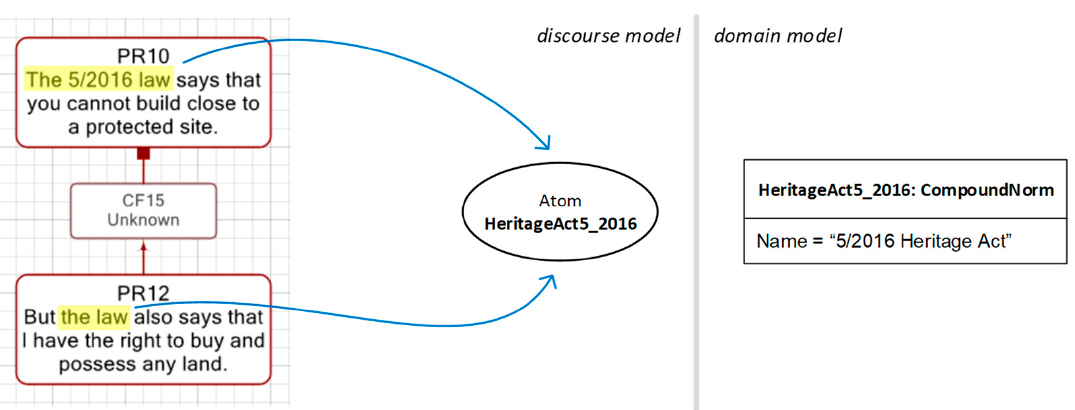
Figure 10. Discourse and domain models for the interpretation that “The 5 / 2016 law” and “the law” refer to the same thing.